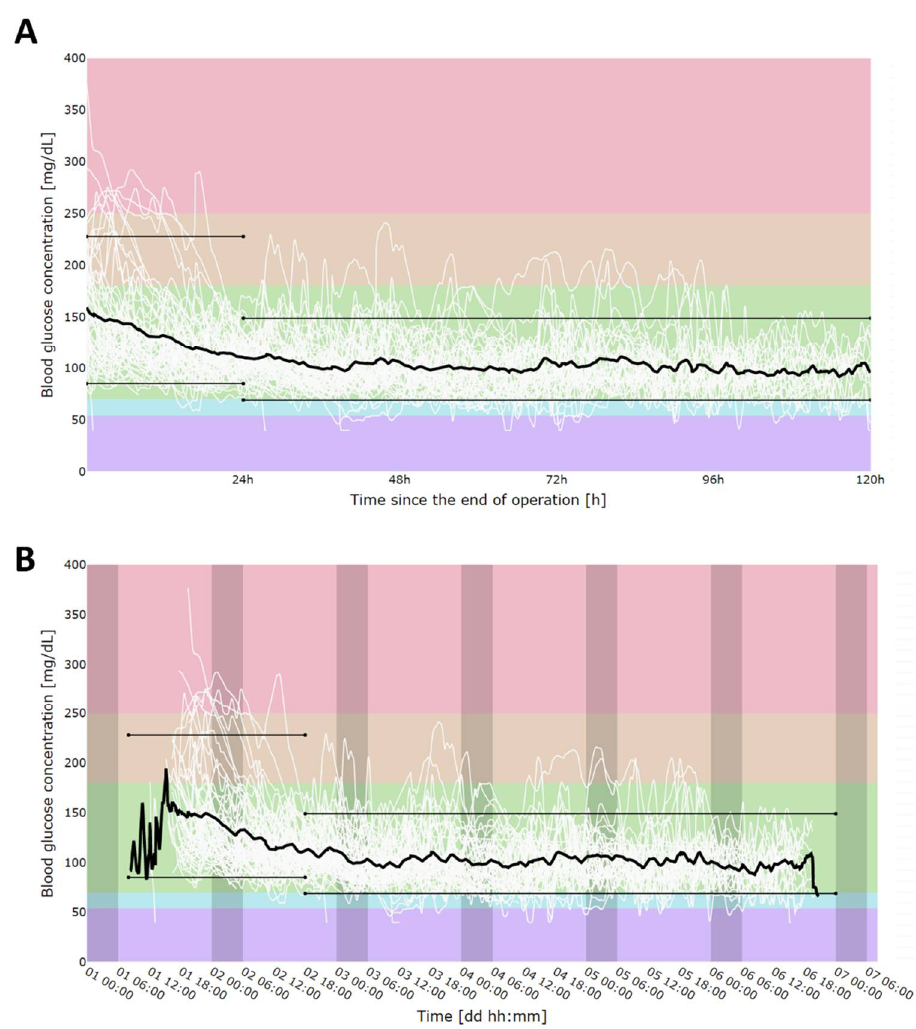
Figure 2. CGM measurement alignment in time since sensor placement ( A ) and in time of day (darker areas show nighttime) ( B ). Solid, black, bold line represents mean. Colors shows different thresholds areas according to current rt-CGM reporting guidelines: hyperglycemia: red (>250 mg/dL), orange (180–250 mg/dL); normoglycemia: green (70–180 mg/dL), hypoglycemia: blue (70–54 mg/dL), violet (>54 mg/dL). Black, thin, parallel lines represent 5th (85 mg/dL for first day and 69 mg/dL for consecutive days) and 95th (228 mg/dL for first day and 149 mg/dL for consecutive days) percentiles for individual rt-CGM measurements. As the first day had significantly higher mean glucose concentration values due to the acute post-operative state, percentiles were calculated separately for the first 24 h after surgery and for the reminder of the post-operative stay (24 h–120 h after the surgery).